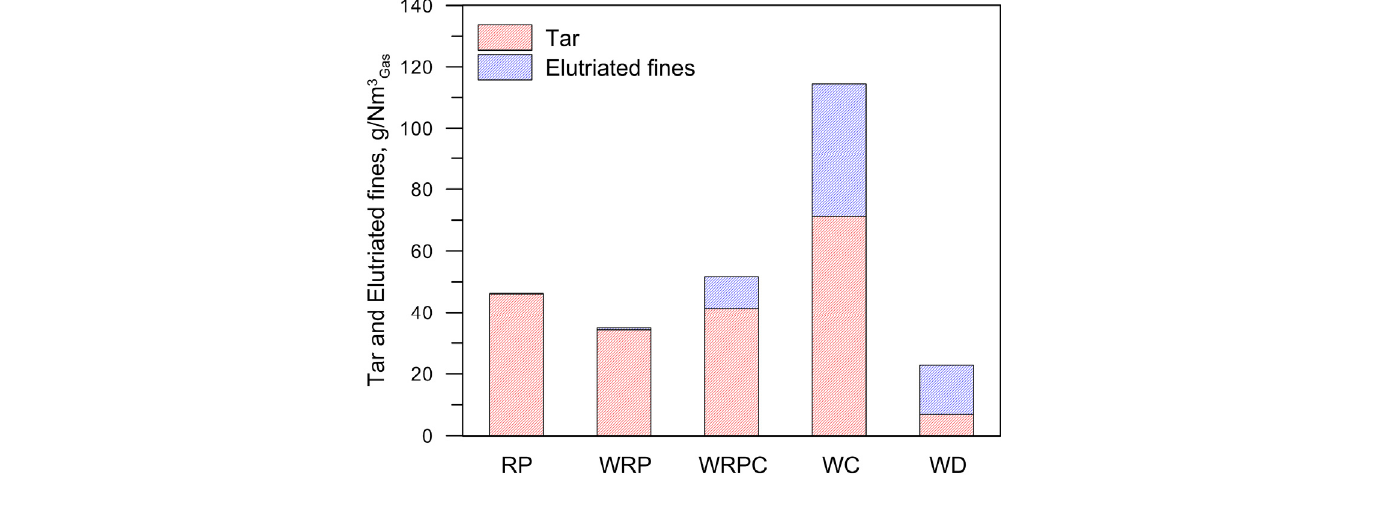
Figure 5. Elutriated fines and tar produced during the gasification tests. Table 4. Main results obtained during the experimental